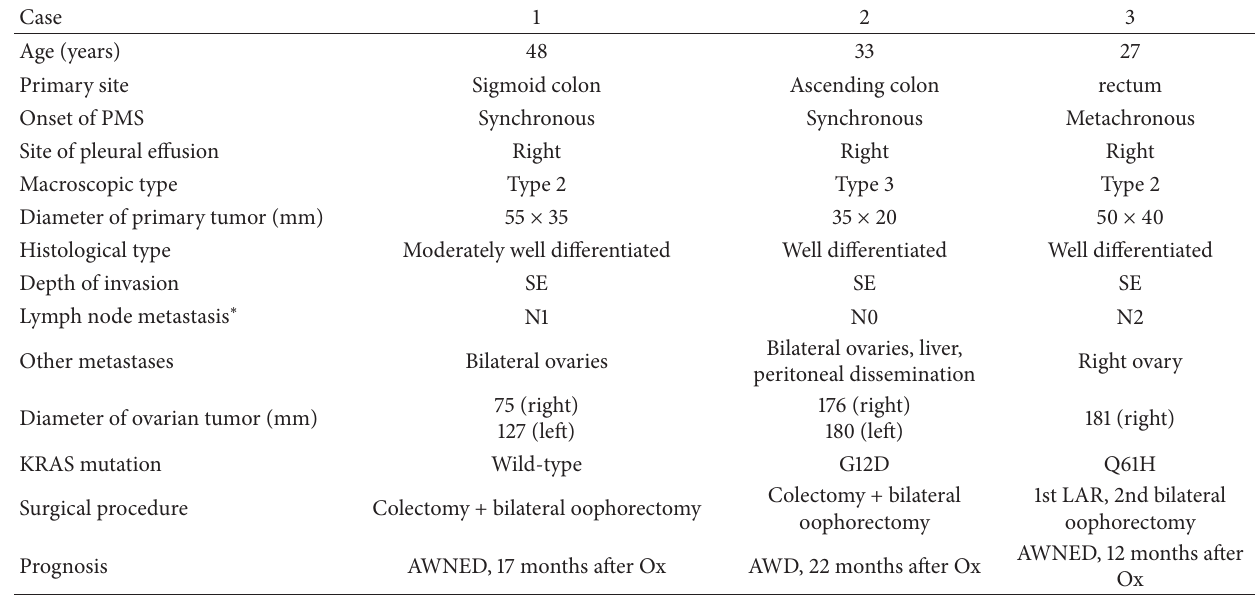
Table 1: Patients’ characteristics.